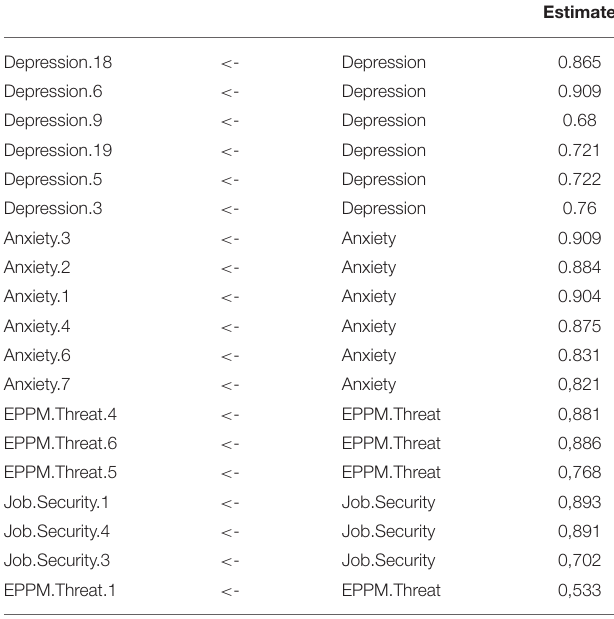
TABLE 3 | Standardized regression weights.